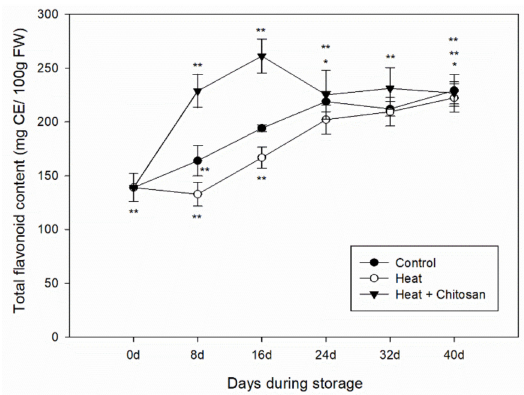
Figure 4. Total flavonoid content of ‘Sanhua’ plum fruit during storage. Error bars represent for standard errors. Control: fruits without treatment; Heat: fruits with hot air treatment at 37 ◦ C for 6 h; Heat and Chitosan: fruits treatment with hot air (37 ◦ C, 6 h) and 1% chitosan. * and ** mean significant di ff erences at p < 0.05 and p < 0.01 level,